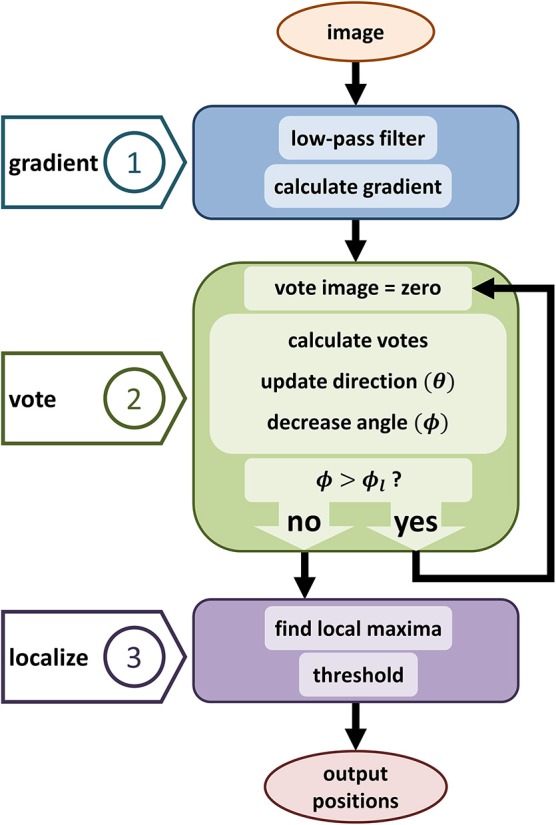
Diagram showing the proposed iterative voting algorithm steps. The first step computes the input gradient. The main step is generating vote image, the same size image as the input. This algorithm iterates through voting steps, to update voting fields and generate a converged vote image. Third step localizes cell positions by using the last vote image.